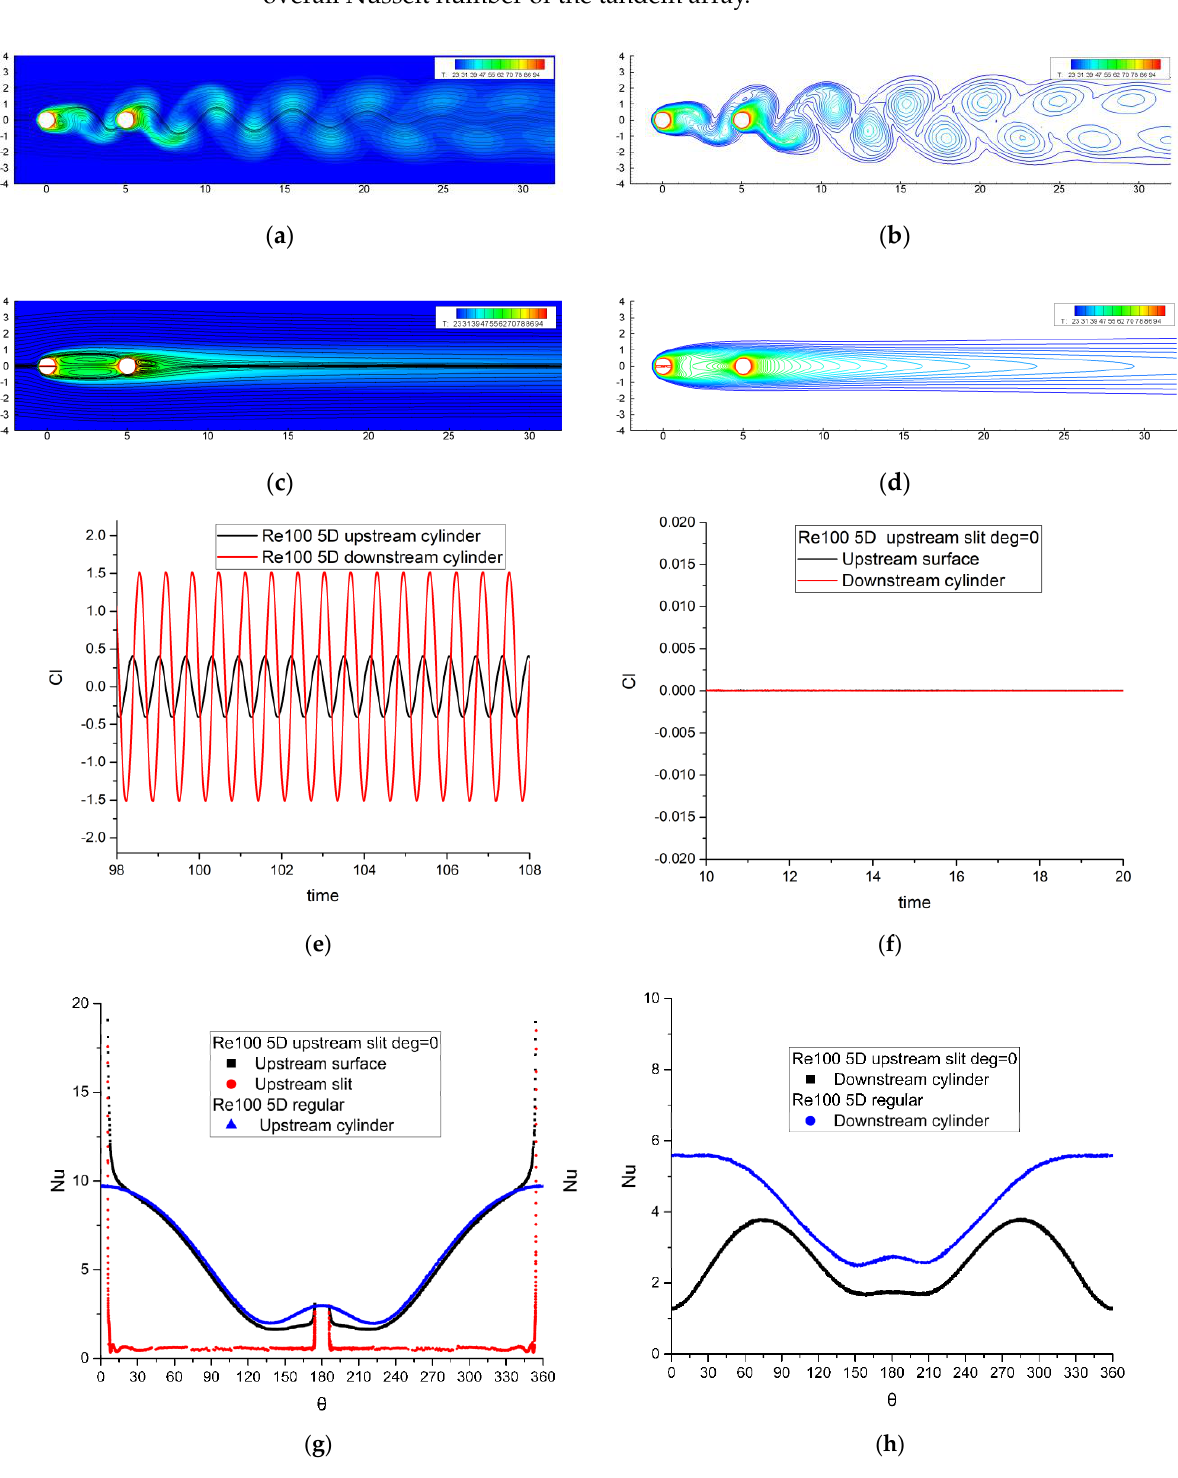
Figure 16. Re = 100, L/D = 5 with slit α = 0° . ( a ‒ c ) Streamlines, temperature contours, and lift history of the regular cylinder array; ( d ‒ f ) streamlines, temperature contours, and lift history of the cylinder array with the slit; ( g ) time mean Nusselt number distribution of the upstream cylinder in regular and slotted array; ( h ) time mean Nusselt number distribution of the downstream cylinder in regular and slotted array.